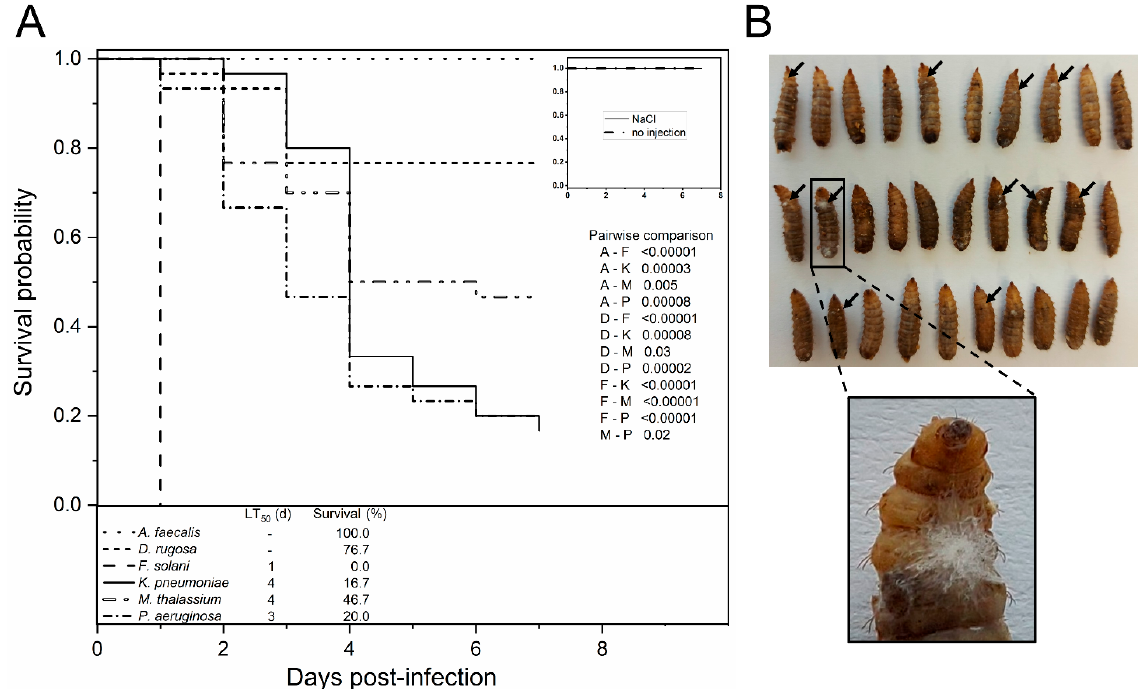
Figure 6. Inoculation of BSF larvae with putative entomopathogens leads to lethality in a species- dependent manner. ( A ) Kaplan-Meier survival functions of 30 larvae injected with 10 6 CFU, conidia, or an equal volume of physiological NaCl (control). Not-injected larvae served as an additional control; larval survival was monitored daily. Lethal time is expressed as LT 50 values (50% deaths). p -Values represent infections compared pairwise by log-rank test, with first letters indicating the genera. ( B ) Images of dead F. solani infected larvae one-day post-inoculation. Melanization of infected tissue and mycelium growing out of the injection site (black arrows) can be